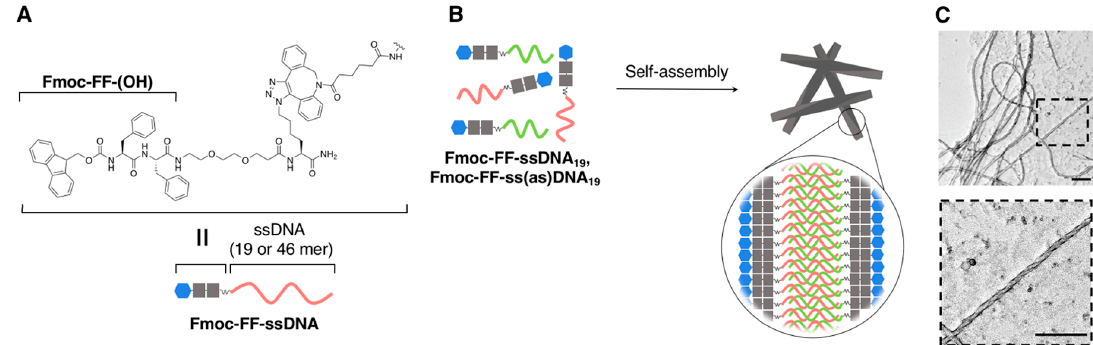
Figure13. ( A )Chemicalstructureof Fmoc-FF-ssDNA s. ( B )Schematicrepresentationoftheself-assembly Figure 13. ( A ) Chemical structure of Fmoc-FF-ssDNA s. ( B ) Schematic representation of the of Fmoc-FF-ssDNA stoformhierarchicalnanostructuresthroughDNAhybridization. ( C )Representative self-assembly of Fmoc-FF-ssDNA s to form hierarchical nanostructures through DNA hybridization. TEM images obtained from co-assembly of Fmoc-FF-ssDNA 19 and Fmoc-FF-ss(as)DNA 19 . Scale bar: ( C ) Representative TEM images obtained from co-assembly of Fmoc-FF-ssDNA 19 and 200 nm. Adapted from [109]. Copyright 2019 American Chemical Fmoc-FF-ss(as)DNA 19 . Scale bar: 200 nm. Adapted from [109]. Copyright 2019 American Chemical Society.